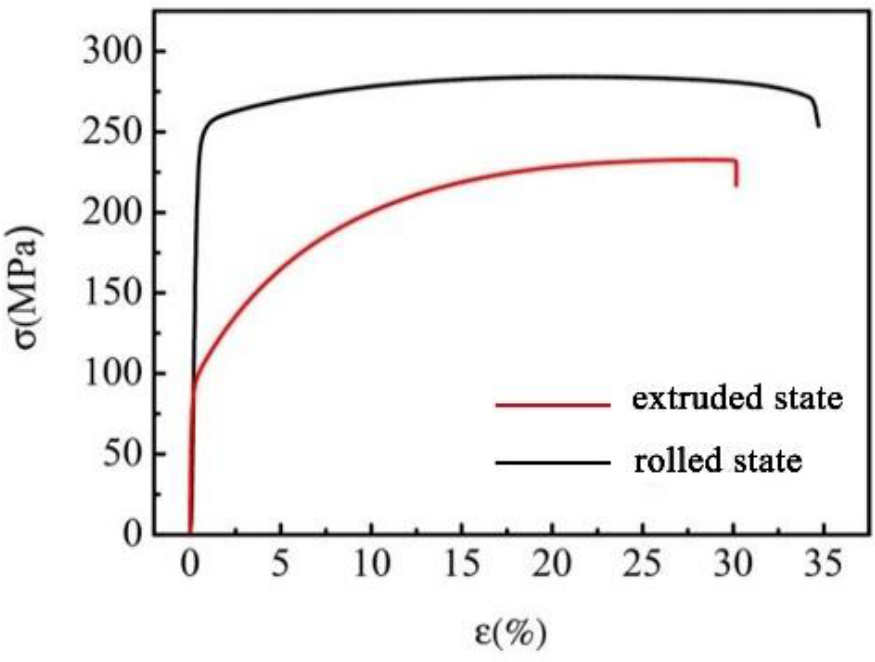
Figure 4. Strain-stress curves of extruded and rolled CdMoO 4 /Cu composites.